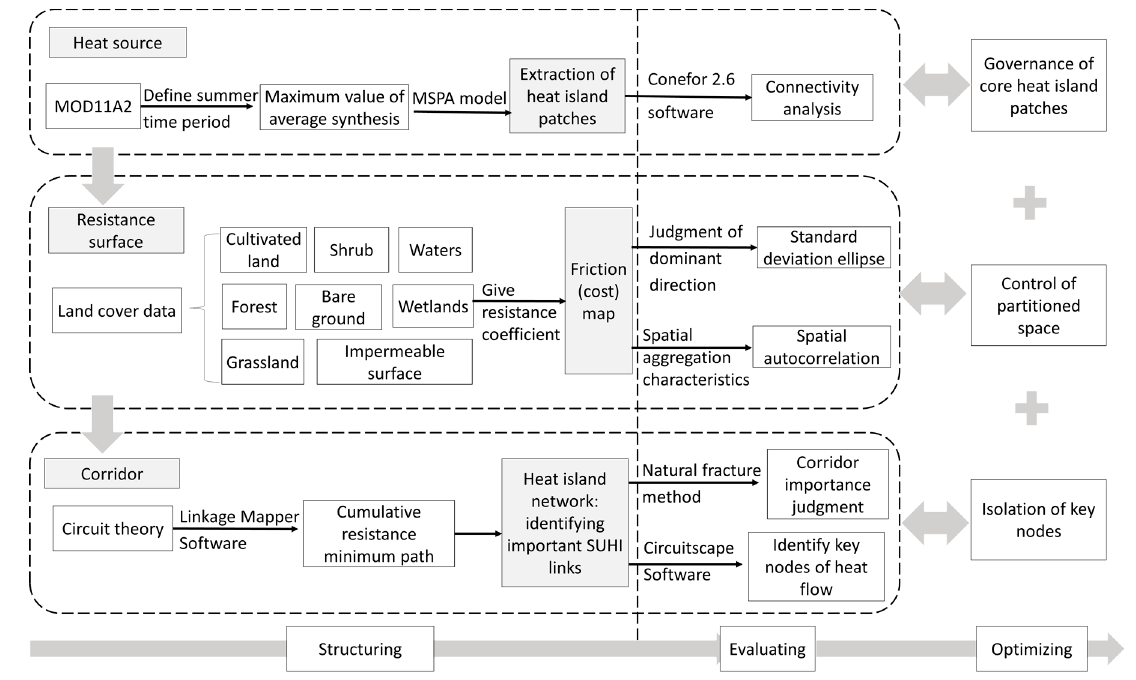
Figure 2. TSPurban’s logical framework of “construction–evaluation–optimization”.